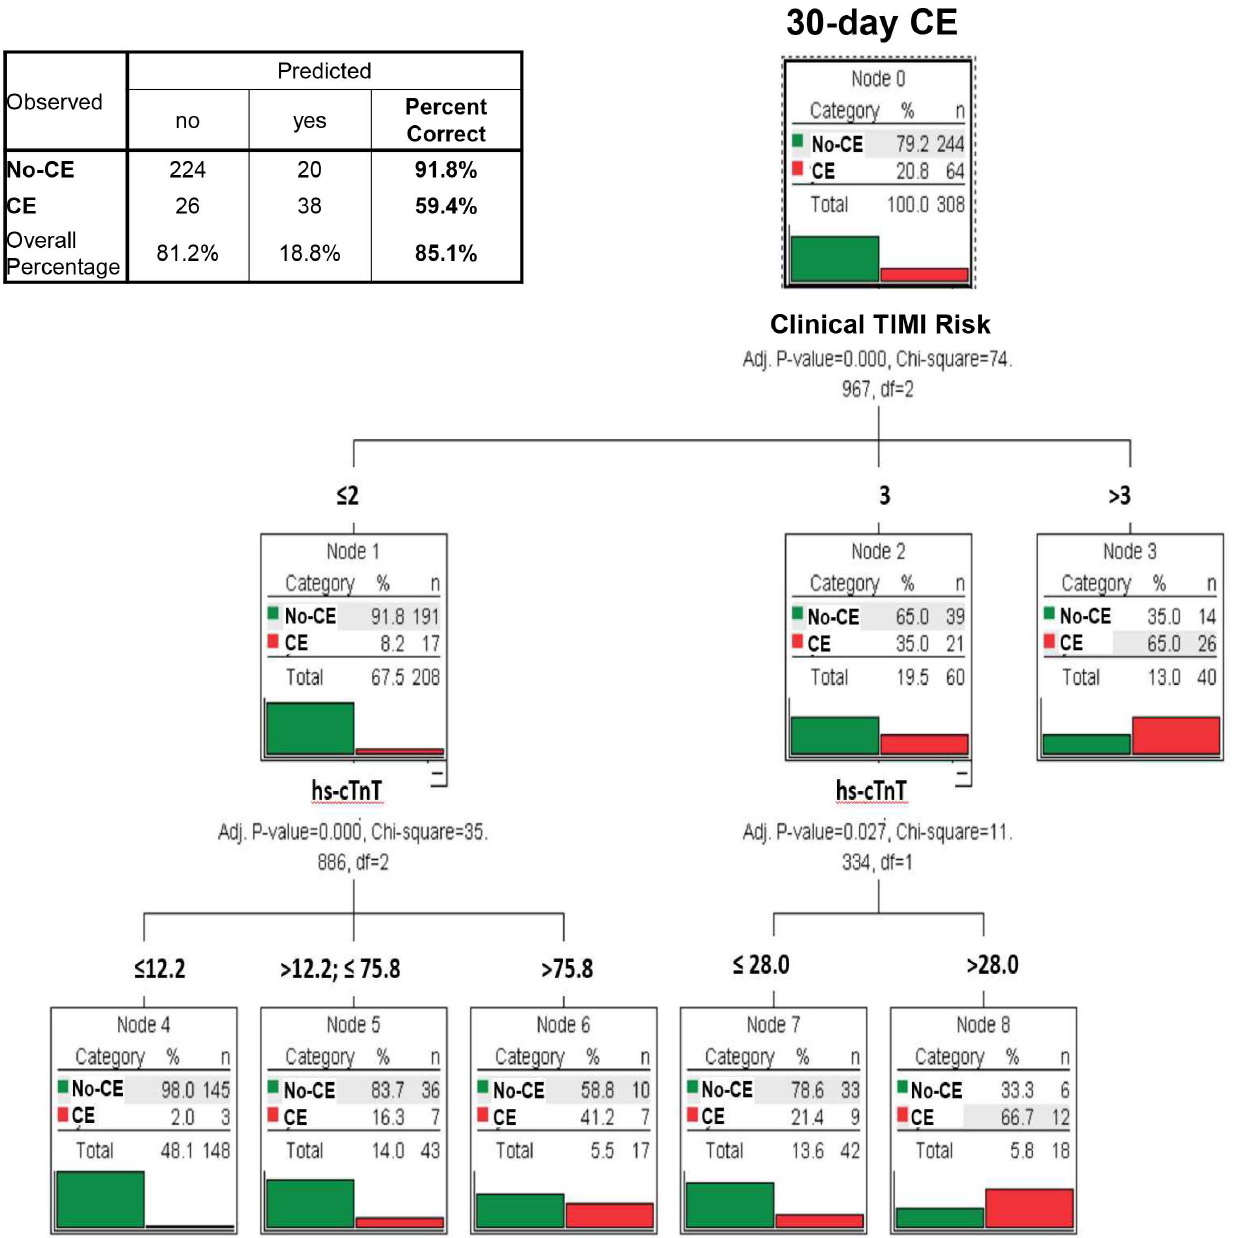
Figure 3. Multivariate classification tree analysis of clinical and multiple biomarker information and the resulting algorithm for the identification of those at risk of cardiac events (CE) within 30 days among patients presenting with suspected ACS and no apparent ST-segment elevations (Non-ST-elevation patients). Hs-cTnT indicates high-sensitive cardiac troponin T (pg/mL), no-CE denotes patients free from cardiac events (CE) within 30 days. The clinical TIMI score is the sum of 6 clinical factors without the biomarker variable of the 7 originally described risk predictors of the TIMI unstable angina/Non-ST myocardial infarction risk score.